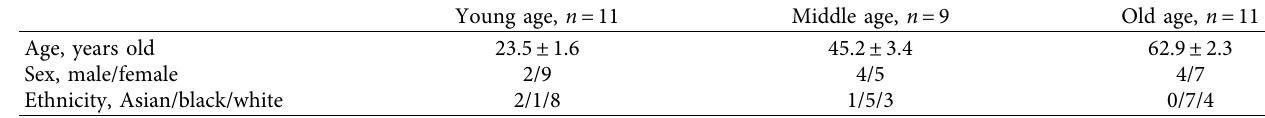
Table 1: Demographic characteristics of study participants.